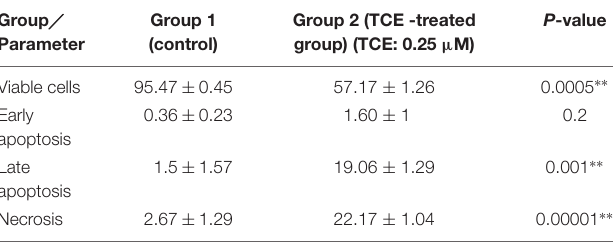
TABLE 2 | Comparison between the studied groups regarding viability, necrosis, and apoptosis in neurospheres by flowcytometry. Group